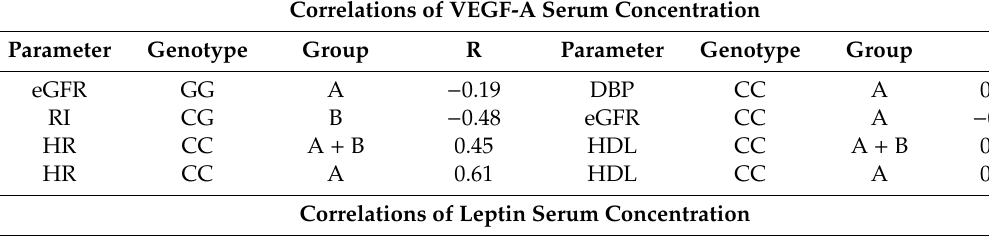
Table 8. Significant correlations of VEGF-A and leptin serum concentrations for rs2010963 ( − 634 G / C) variant of VEGF gene. Group A-study group. Group B-control group.